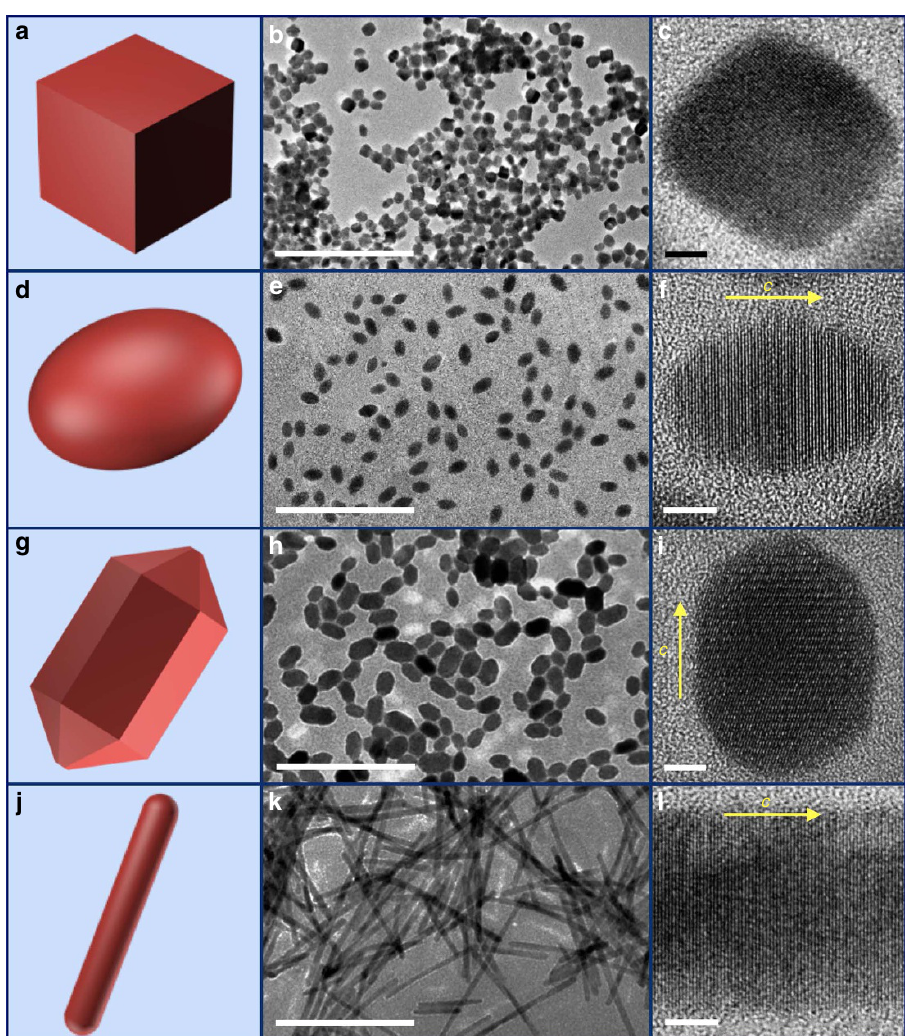
Figure 3 | The a -HgS nanostructures with chiral lattice (( þ ) C ) but various achiral morphology. ( a – c ) Model, typical large-scale TEM image and high-resolution TEM image of nanocubes, respectively. ( d – f ) Model, typical large-scale TEM image and high-resolution TEM image of nanoellipsoids, respectively. ( g – i ) Model, typical large-scale TEM image and high-resolution TEM image of nanorods, respectively. ( j – l ) Model, typical large-scale TEM image and high-resolution TEM image of nanowires (denoted as ‘Nanowires 1’), respectively. More nanowires with different aspect ratio are provided in Supplementary Fig. 12. The yellow arrow in f , i and l represents crystallographic c axis of a -HgS. Scale bar for large-scale TEM images, 200nm. Scale bar for high-resolution TEM images